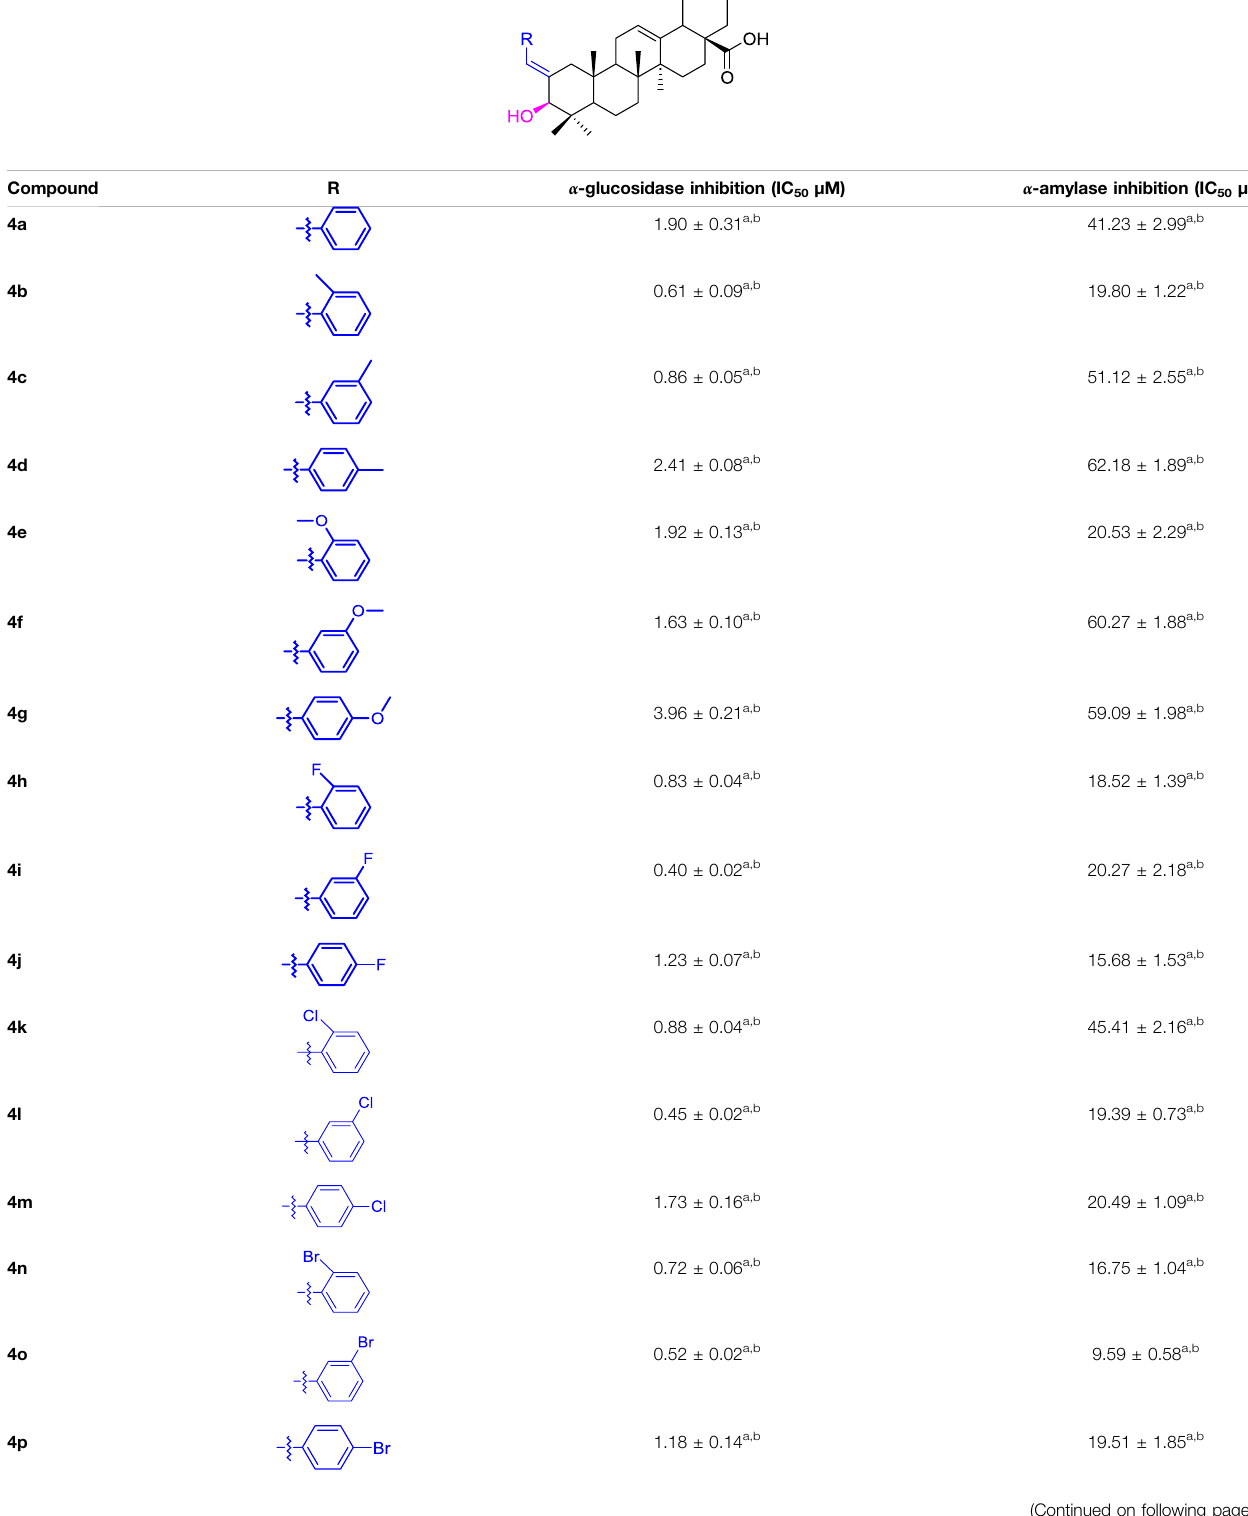
TABLE 1 | Inhibition of OA analogs ( 4a – 4s ) on α -glucosidase and α -amylase.